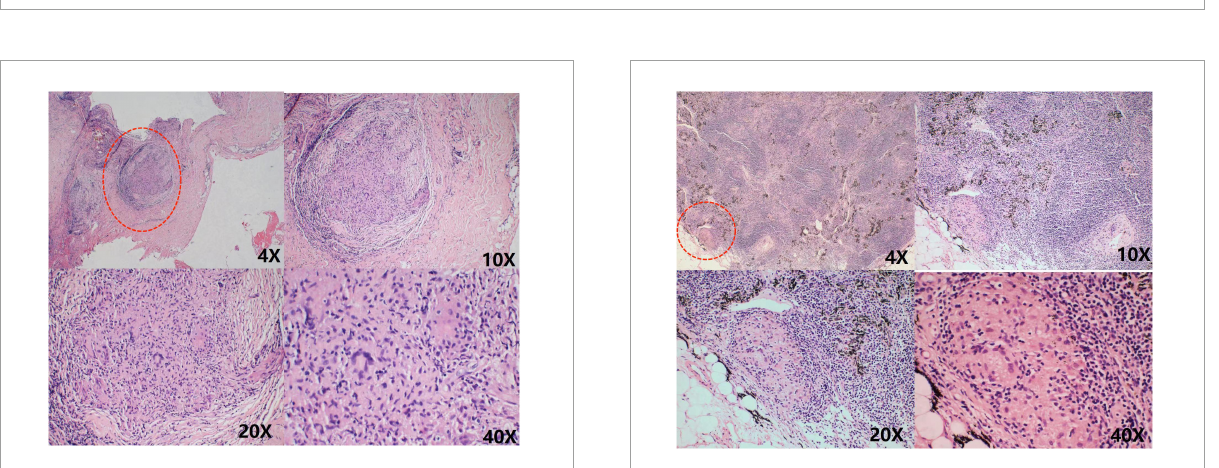
FIGURE5 Granulomatous lesions are seen within the fibrofatty tissue, as shown in the red circle.